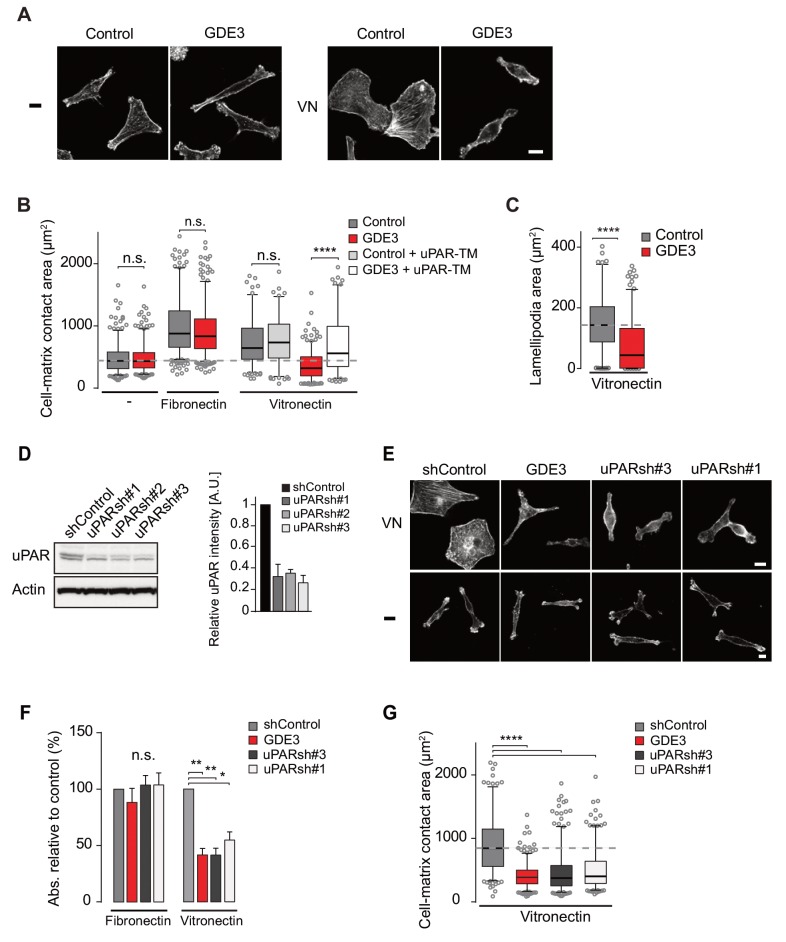
GDE3 suppressess the vitronectin- and uPAR-dependent transformed phenotype of MDA-MB-231 breast cancer cells.A) Confocal images showing that GDE3 prevents cell spreading and lamellipodia formation on vitronectin (VN) but not on uncoated cover slips (-). Bar, 10 μm. (B) Quantification of reduced cell spreading on vitronectin by GDE3. Non-cleavable uPAR-TM prevents GDE3 attack. ****p<0.0001; n.s., not significant. (C) Quantification of lamellipodia formation on vitronectin. ****p<0.0001. (D) Immunoblot analysis of shRNA-mediated uPAR knockdown; maximum knockdown was achieved by small hairpins #1 and #3. The upper protein band represents full-length uPAR, the lower band proteolytically cleaved uPAR(D2 +D3) (Høyer-Hansen et al., 1992). (E) GDE3 overexpression mimics the uPAR knockdown phenotype in cells plated on vitronectin (VN); bar, 10 μm. (-) denotes cells on non-coated cover slips. (F,G) Quantification of cell adhesion (F) n = 3; mean ±SEM) and cell spreading (G) induced by GDE3 and uPAR knockdown on the indicated substrates. *p<0.05 **p<0.01; ****p<0.0001. GDE3 overexpression attenuates the uPAR-dependent transformed phenotype of breast cancer cells.